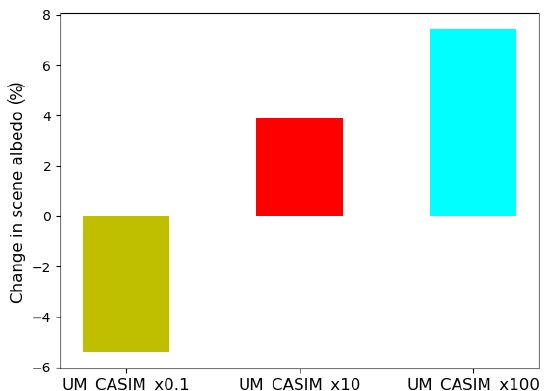
Figure 8. Percentage change in scene albedo for each of the per- turbed aerosol simulations, relative to the baseline UM_CASIM case, calculated using time and domain mean synthetic cloud albedo and cloud fraction, as shown in Eq.